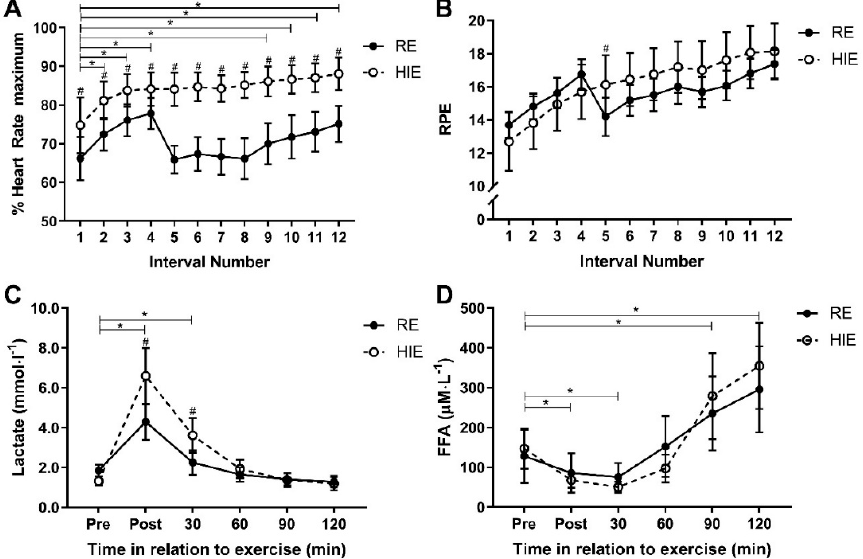
Figure 3. Responses to high-intensity interval exercise (HIE) and resistance exercises (RE) for % heart rate maximum ( A ), rating of perceived effort ( B ), blood lactate concentrations ( C ) and plasma free fatty acid concentrations ( D ). Data shown are mean and 95% CI. # Indicates a post hoc difference between exercise mode after a significant interaction effect was identified ( p < 0.05). * Indicates a significant pairwise comparison after Bonferroni correction ( p < 0.05) tested after a significant main effect for time was identified. For rate of perceived exertion (RPE), there were significant pairwise comparisons for time for all intervals in comparison to the first interval. Time of measurement for % heart rate maximum and RPE were at the completion of each work interval for both HIE and RE. Time of measurements for lactate and free fatty acids (FFA) were immediately pre- and post-exercise, and then 30, 60, 90 and 120 min after the completion of exercise.